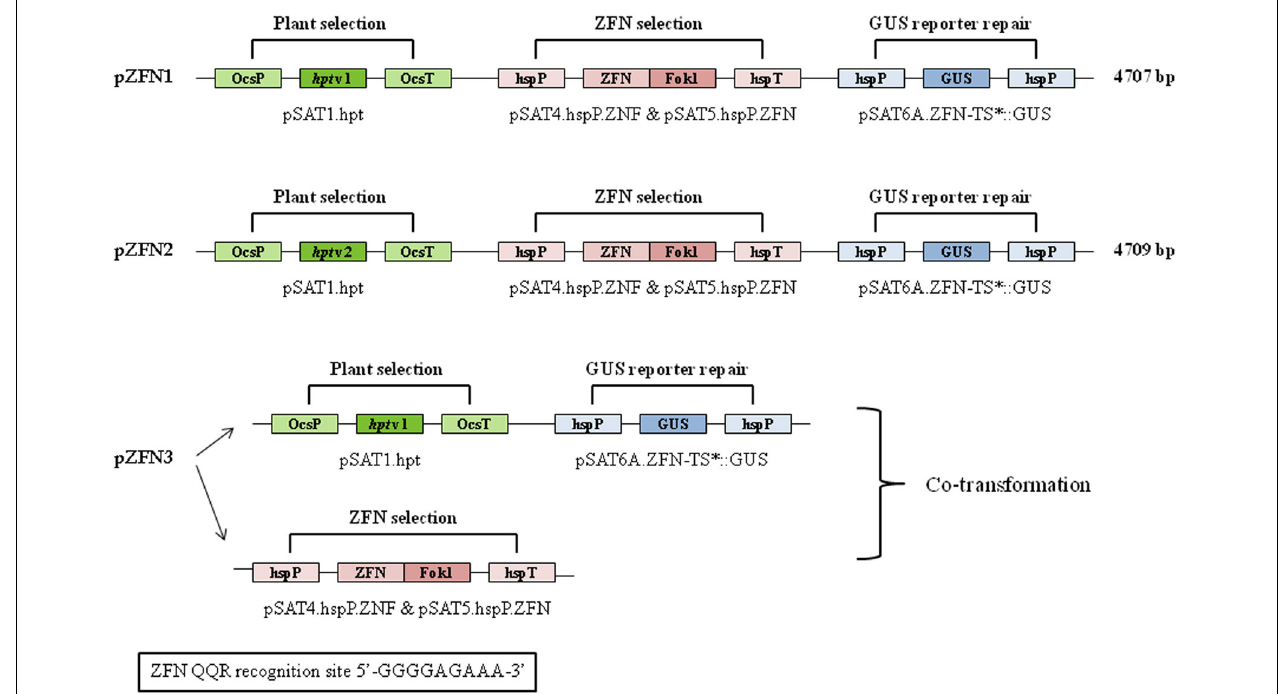
FIGURE 1 | Structure and key features of the pZFN1, pZFN2, and pZFN3 constructs. The vector system is based on the assembly of ZFN expression cassettes (pSAT4.hspP.ZFN and pSAT5.hspP.ZFN), a plant selection expression cassette (pSAT1.hpt), and GUS reporter cassette (pSAT6A.ZFN-TS ∗ ::GUS) onto the plant binary vector pRCS2. Asterisk stands